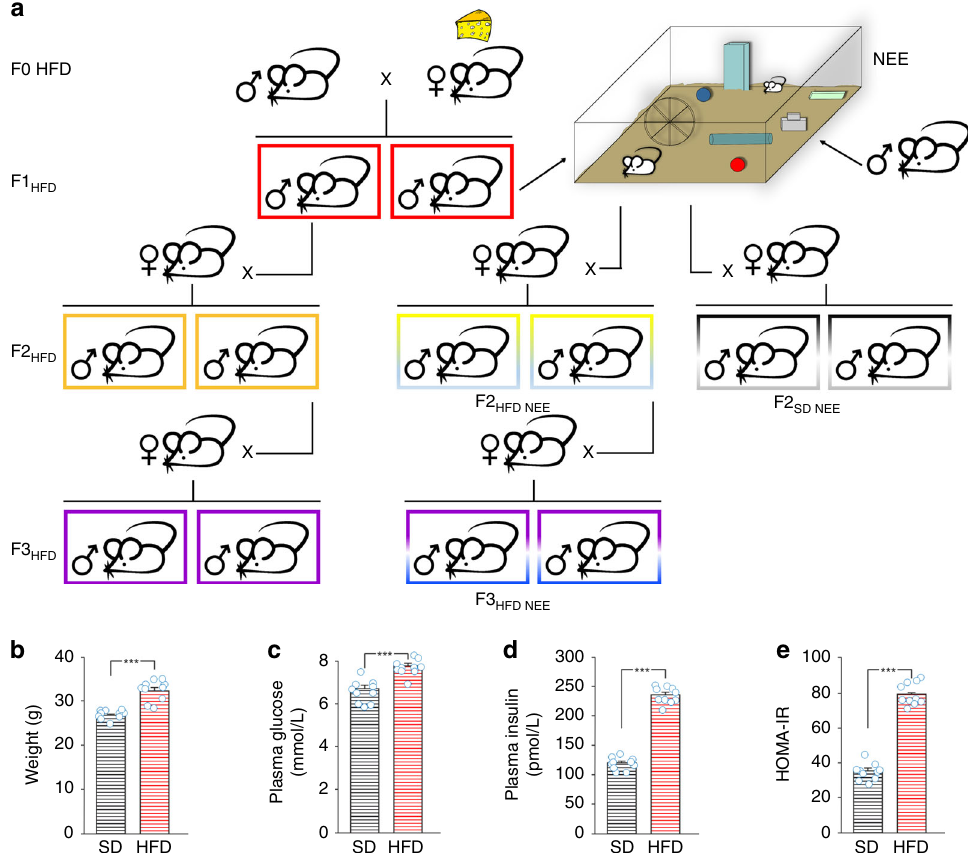
Fig. 1 Experimental model. a Female mice (F0) were fed with either standard or high-fat diet (F0 SD and F0 HFD, respectively) for 4 weeks before mating with control males fed with SD. Unless otherwise speci fi ed, HFD was maintained during the pregnancy and until the second week of lactation. The